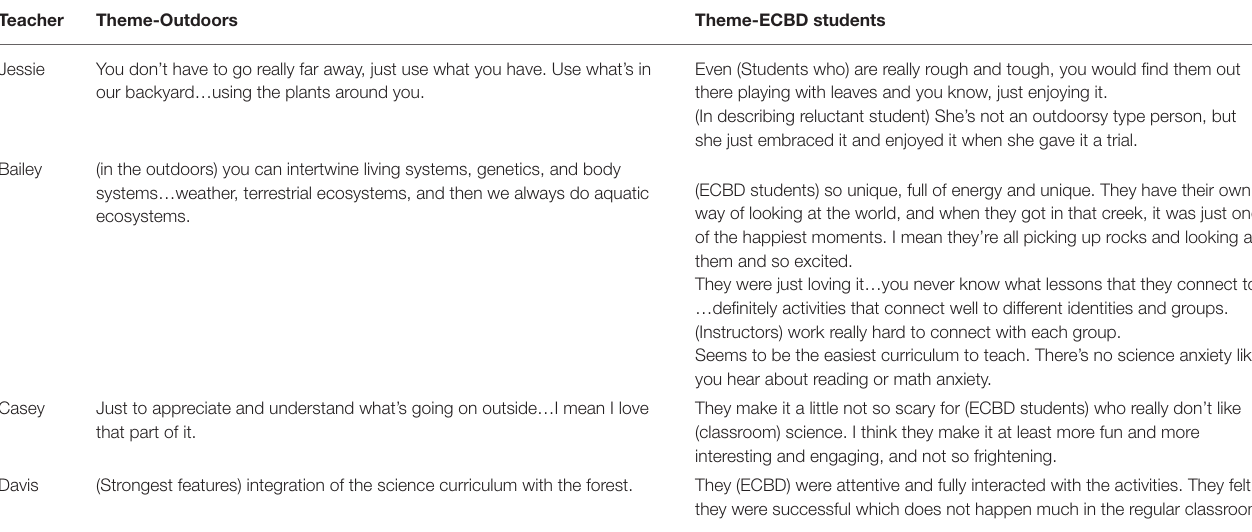
TABLE 3 | Emergent themes from interviews with